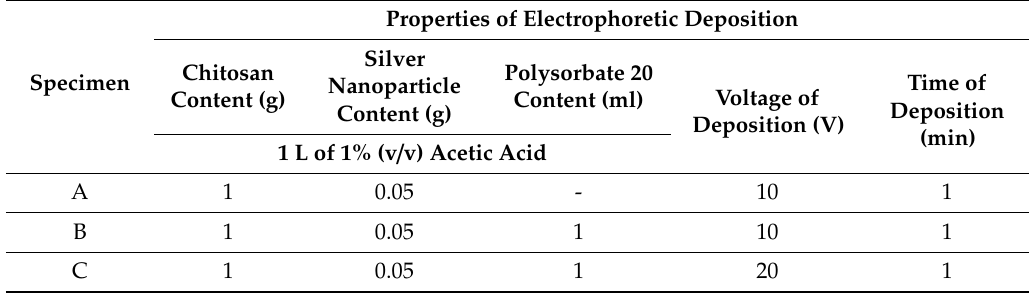
Table 2. Test variables, their investigated combinations, and further